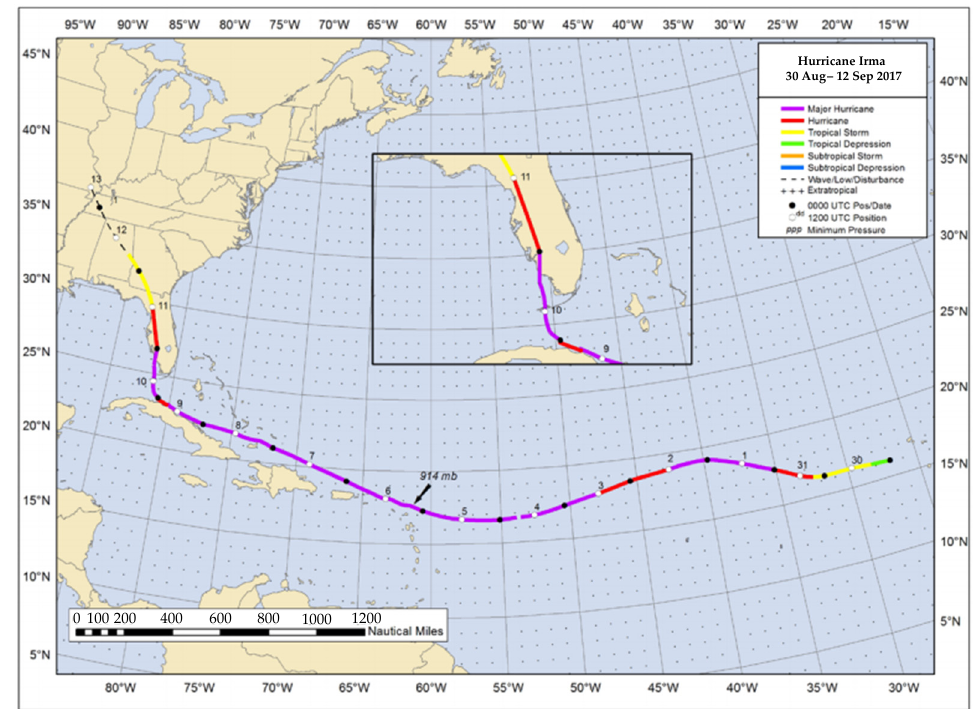
Figure 8. Track of Hurricane Irma through the Atlantic Ocean, Caribbean, and Florida from 30 August to 12 September 2017. The inset shows the path of Hurricane Irma as it hit Florida on 10 September 2017. From National Hurricane Center Tropical Cyclone Report [32].